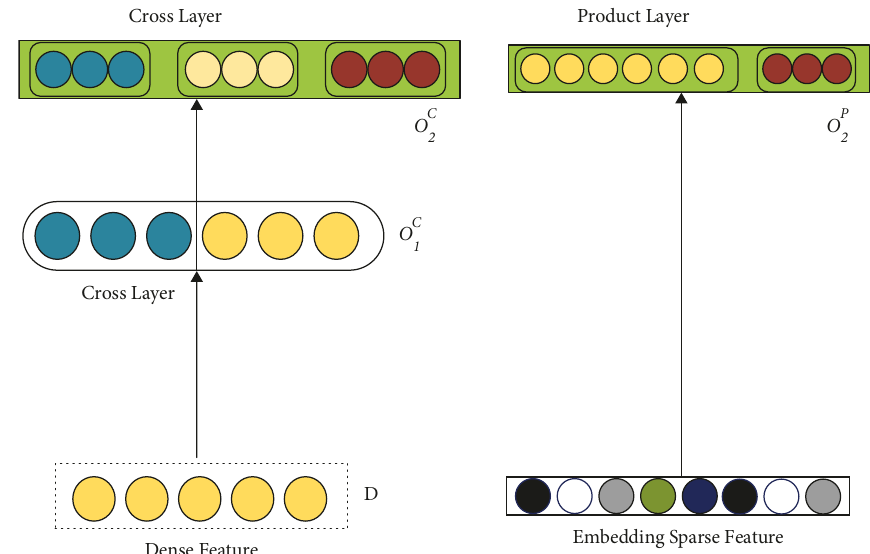
Figure 2: The network structure of Double Cross Net, including the cross layer and product layer.